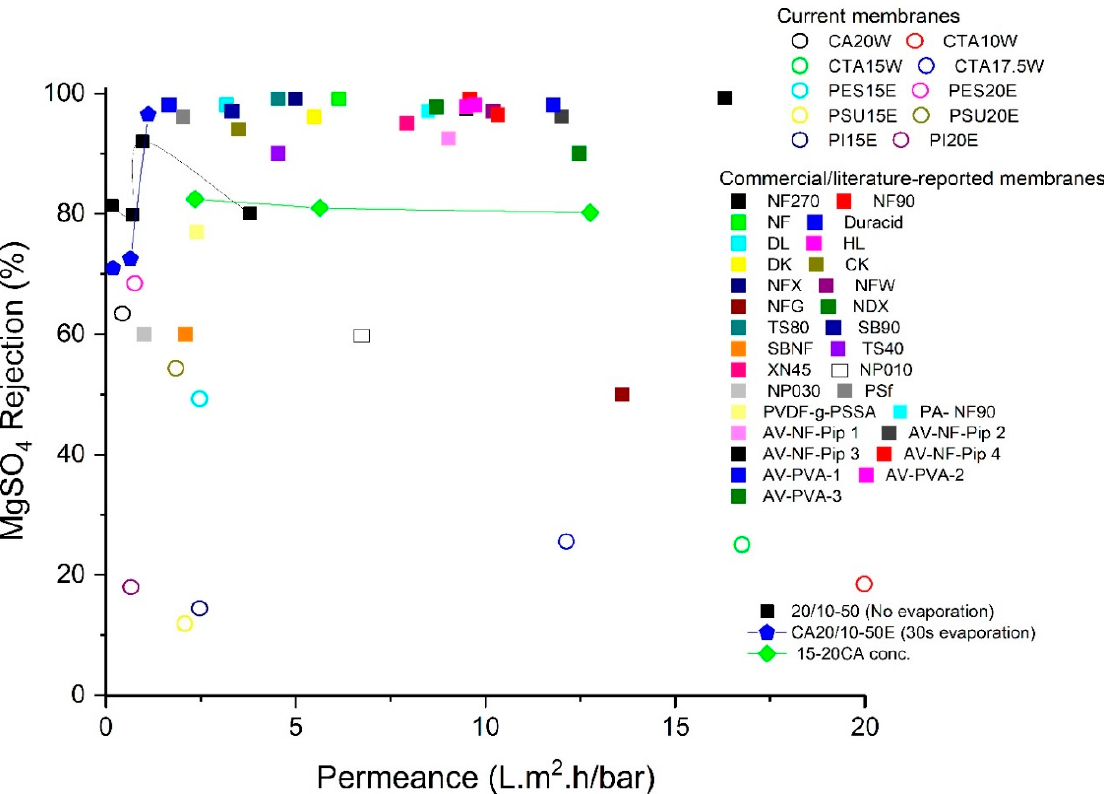
Figure 15. Rejection-permeance plot for membranes (which already qualified to be loose NF membranes based on the RB-data), and their comparison with a selection of commercial and literature-reported membranes using MgSO 4 /H 2 O as feed solution.